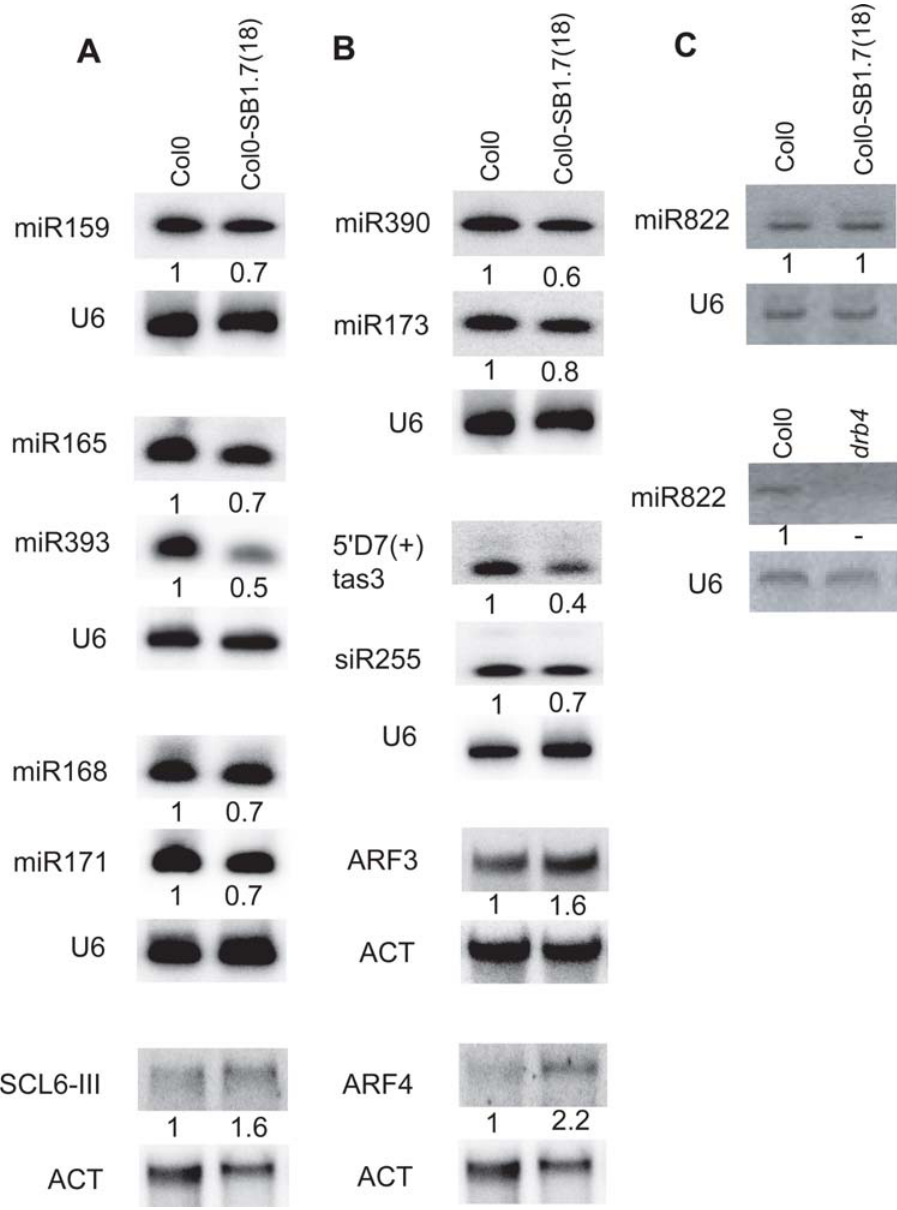
Figure 5. Molecular impact of SINE transcription on the different mi/tasiRNA pathways. A. Molecular impact on the miRNA pathway. Examples of five miRNAs that accumulate to lower levels in flowers from SINE expressing individuals (Col0-SB1.7(18)) compared to wild type (Col0). The correlative increase of the miR171-targeted SCL6-III mRNA is shown. B. Molecular impact on the tasiRNA pathway. The two miRNAs known to prime the synthesis of the tasiRNA precursors (miR173 for TAS1 and 2 and miR390 for TAS3) accumulate to a lower level in flowers from SINE expressing individuals (Col0-SB1.7(18)) compared to wild type (Col0). Consequently mature tasiRNA products (5 9 D7( + ) TAS3, siR255 TAS1) are less abundant in SINE expressing individuals and messenger RNA targets of TAS3 (ARF3 and ARF4 mRNAs) are over-represented. C. The accumulation of the DCL4-DRB4-dependent miR822 [54] is unchanged in the Col0-SB1.7(18) transgenic line but miR822 is undetectable in the drb4 mutant line. The relative proportion of miRNA, tasiRNA and mRNAs (the mean of at least three experiments) normalized using the U6 RNA or Actin mRNA signal is indicated. Similar results were obtained using the Col0-SB1.7(4) transgenic line.